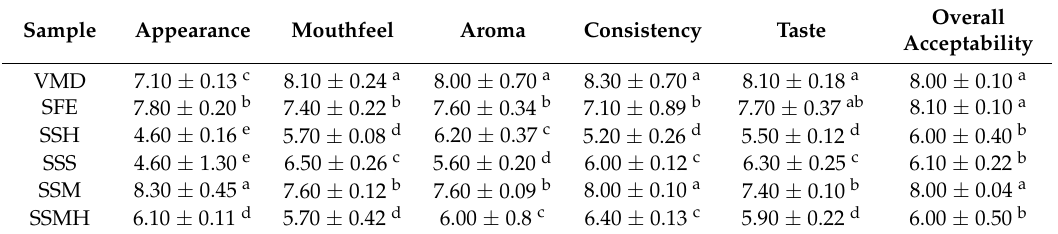
Table 5. Sensory attributes of formulated soursop